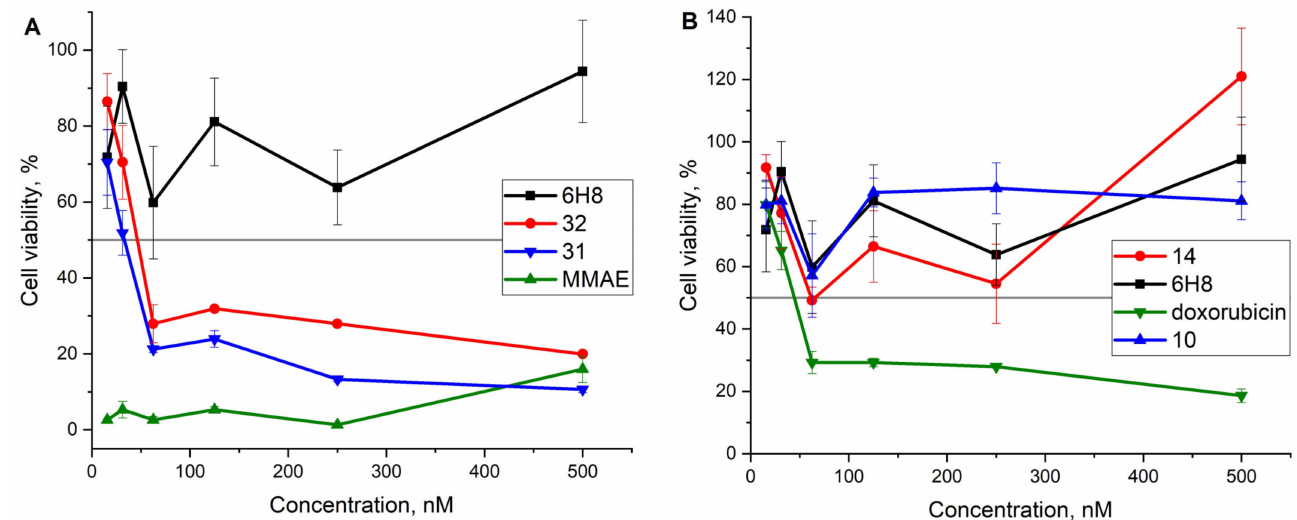
Figure 8. Viability of PRAME (+) human acute monocytic leukemia cell line THP-1 analyzed by MTT assay following 72 h incubation with 31 , 32 , MMAE, and 6H8 mAb ( A ); 14 , 10 , doxorubicin,